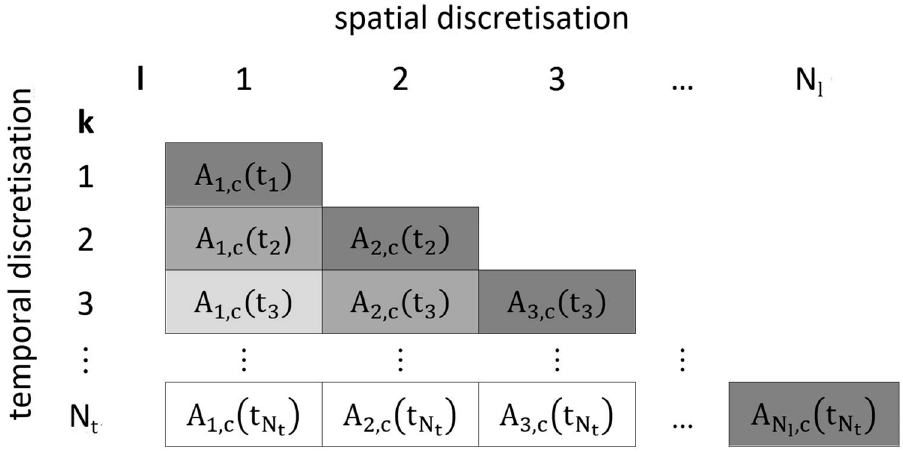
Figure 1. Discretisation approach for IM = 1.